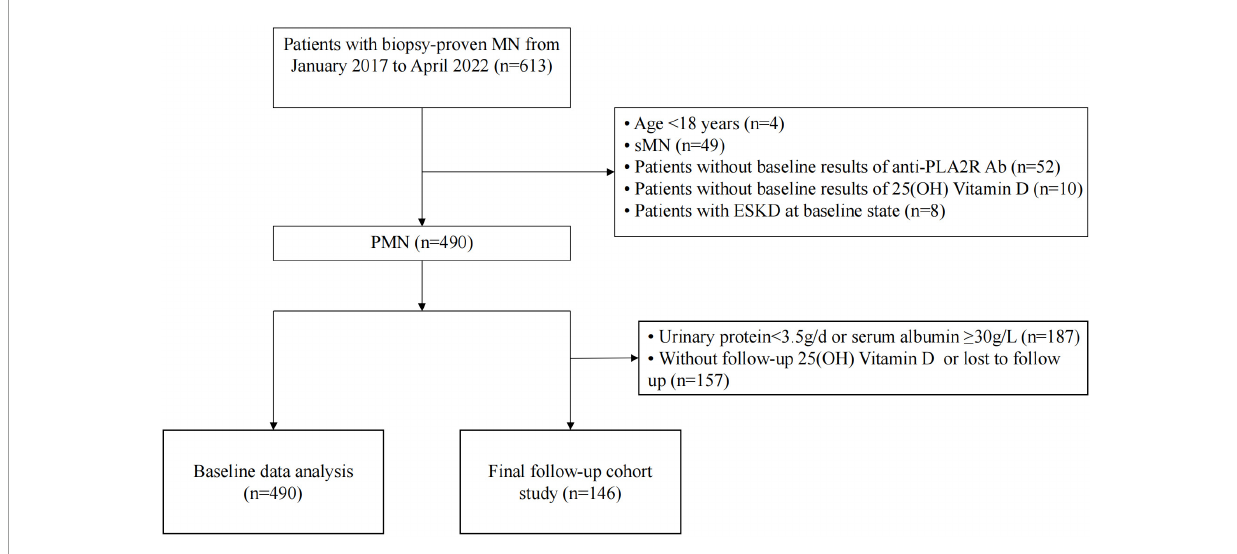
FIGURE1 Flowchart of study participants. PMN, primary membranous nephropathy; sMN, secondary membranous nephropathy; anti-PLA2R Ab, anti-phospholipase A2 receptor antibody; 25(OH)D, 25-hydroxyvitamin D; ESKD, end-stage kidney disease.